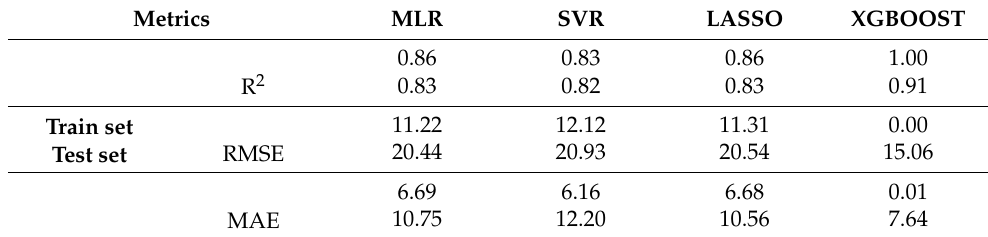
Table 3. Evaluation Metric Scores of the Models.